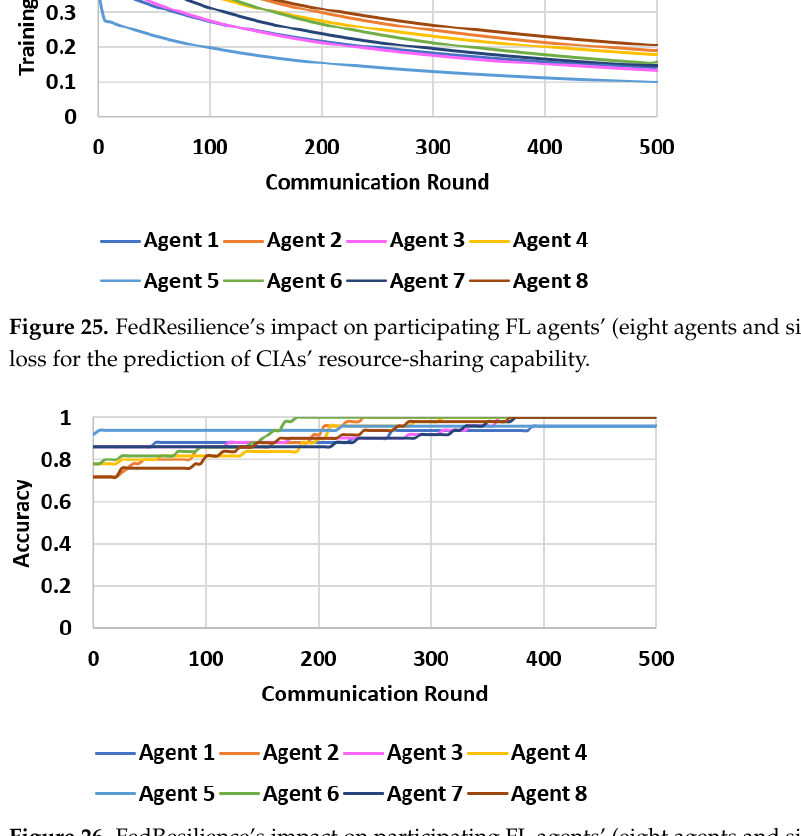
Figure 26. FedResilience’s impact on participating FL agents’ (eight agents and six stragglers) model accuracy for the prediction of CIAs’ resource-sharing